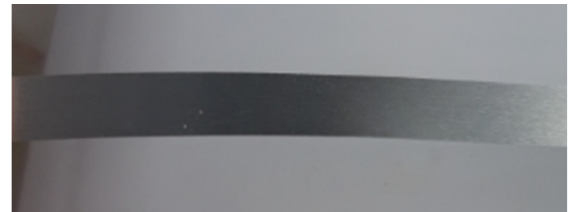
Figure 1. Anodized aluminum strip.